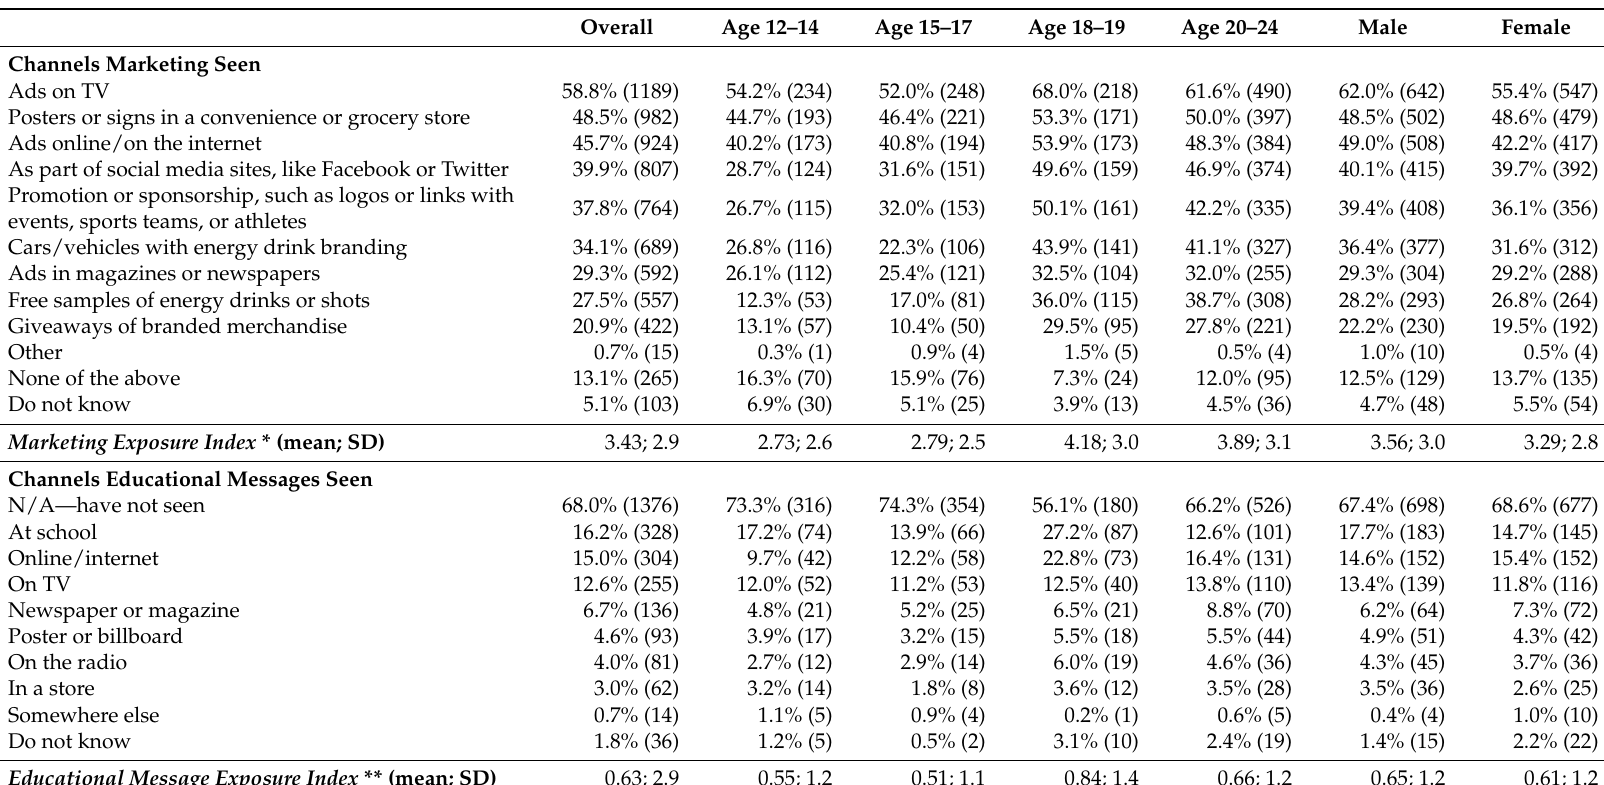
Table 2. Channels where energy drink marketing and educational messages were ever seen, overall, as well as by age group and sex ( n =